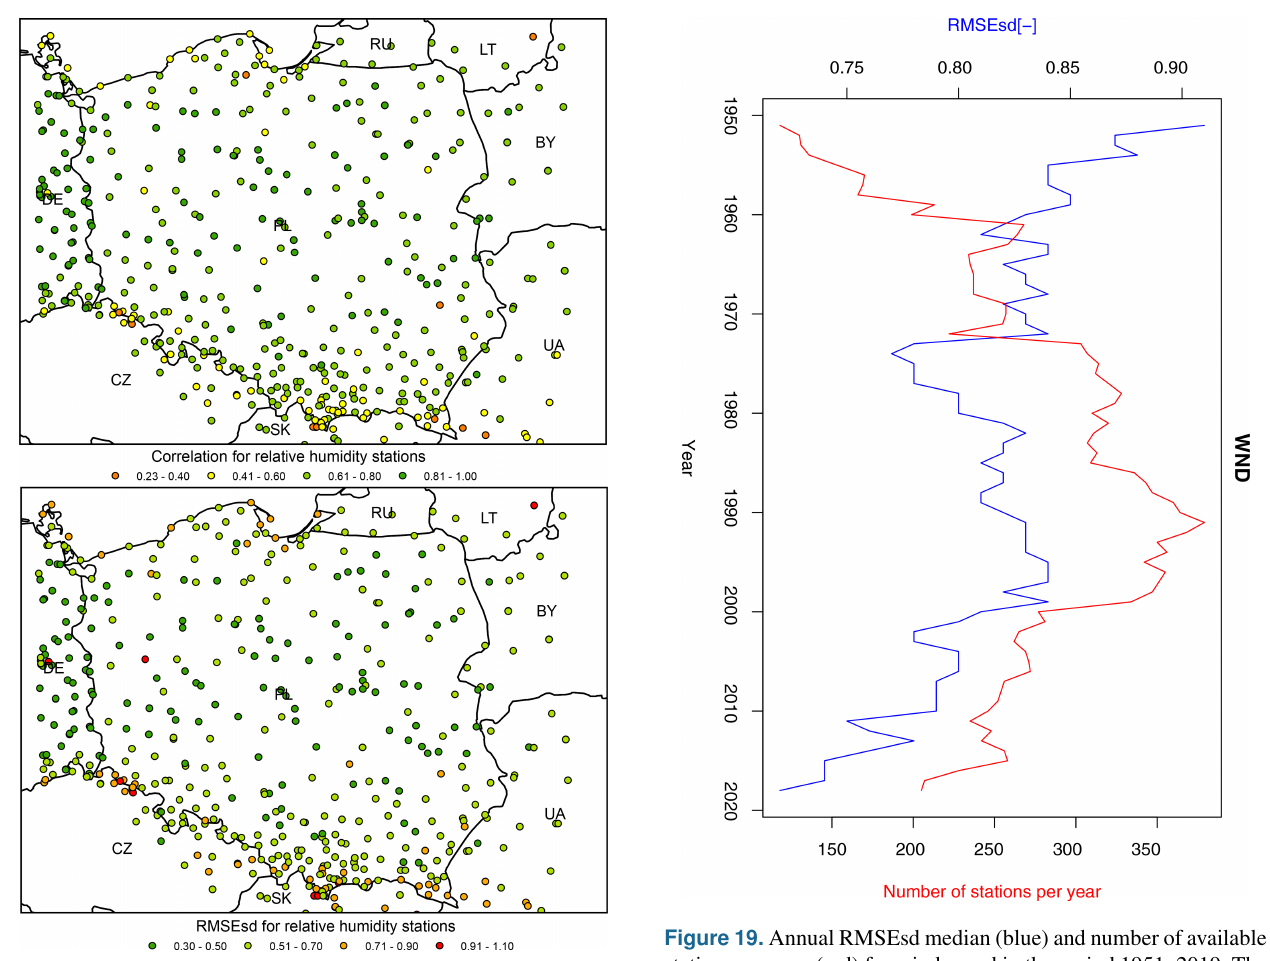
Figure 18. Relative humidity ρ (top) and RMSEsd (bottom) values calculated for stations in the period 1951–2019. National borders (black lines) are labelled with country codes.